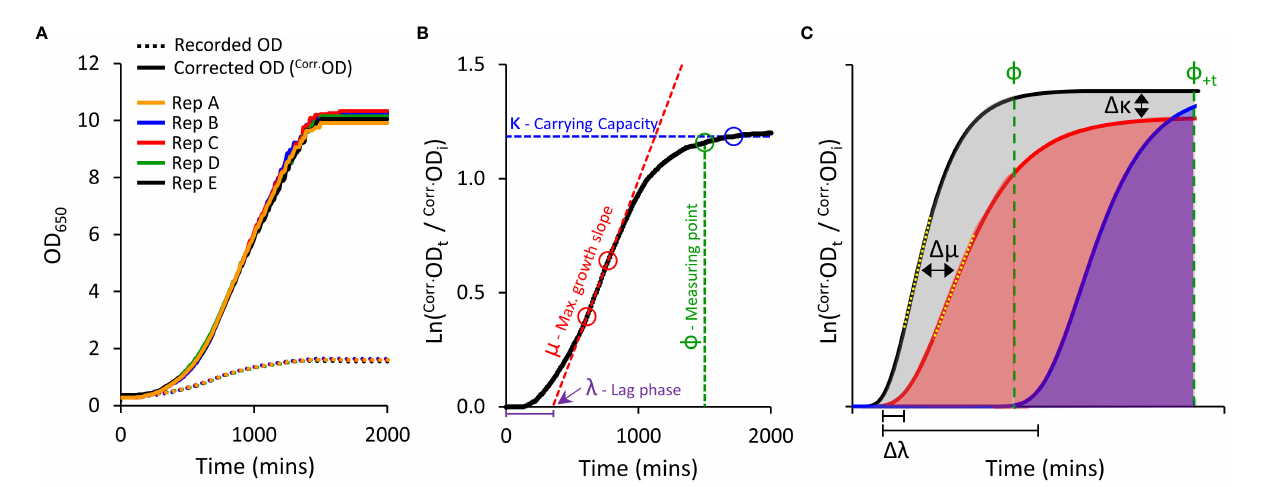
FIGURE 1 Yeast micro-cultivation setup and growth data outputs. (A) , Optimised micro-cultivation conditions produce repeatable growth curves of replicate cultures spaced across a 96-well plate. The growth curves of recorded OD values are compressed due to the progressive non-linear response of optical detection. Applying a calibration function produces corrected OD values ( Corr. OD) and a more accurate representative growth curve. (B) , A yeast population growth curve (Ln Corr. Od t / Corr. Od i ) depicting the three major derived growth traits ( l , m , and k ) and the dynamic standardizing measuring point, Phi ( ф ). (C) , Conceptual examples demonstrating the use of Area Under the Curve (AUC) as a measure of cumulative growth differences. Untreated yeast population growth (black) and two treatment growth scenarios (blue and red). Ф is allocated to the untreated growth curve. The red curve shows a slightly longer lag phase ( Dl ), reduced maximum rate of growth ( Dm ; differences between yellow dotted tangent lines), and lower carrying capacity ( Dk ), captured as a substantially reduced AUC (shading) than that of the untreated black curve. The blue curve shows a longer lag phase, but growth rate and carrying capacity similar to untreated. No AUC is detected at ф , but AUC can be detected by shifting to ф +t (note: D AUC will be less (underestimated) when using ф +t as control population has ceased